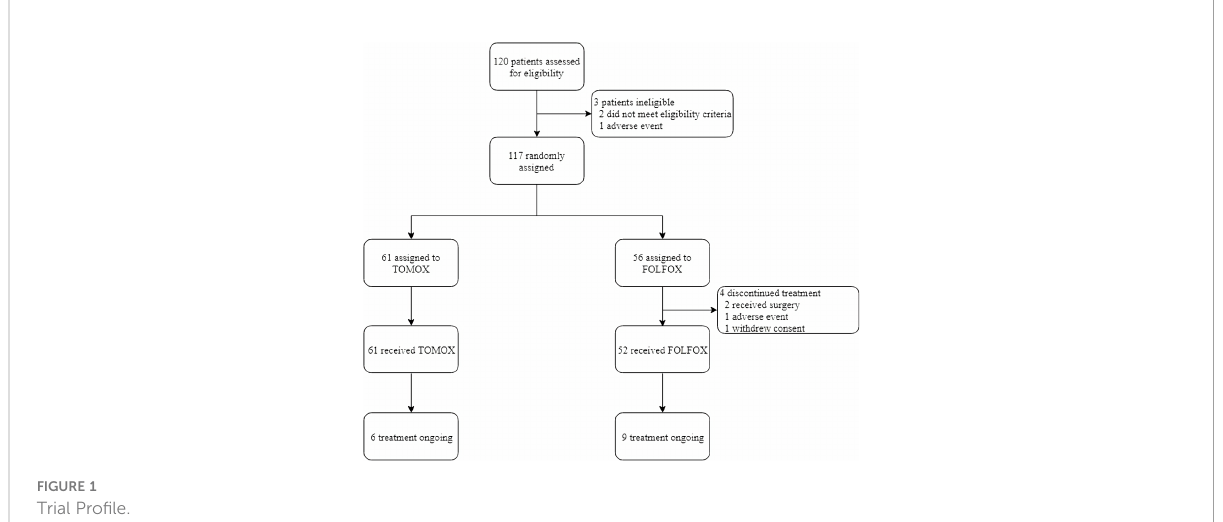
FIGURE 1 Trial Pro fi